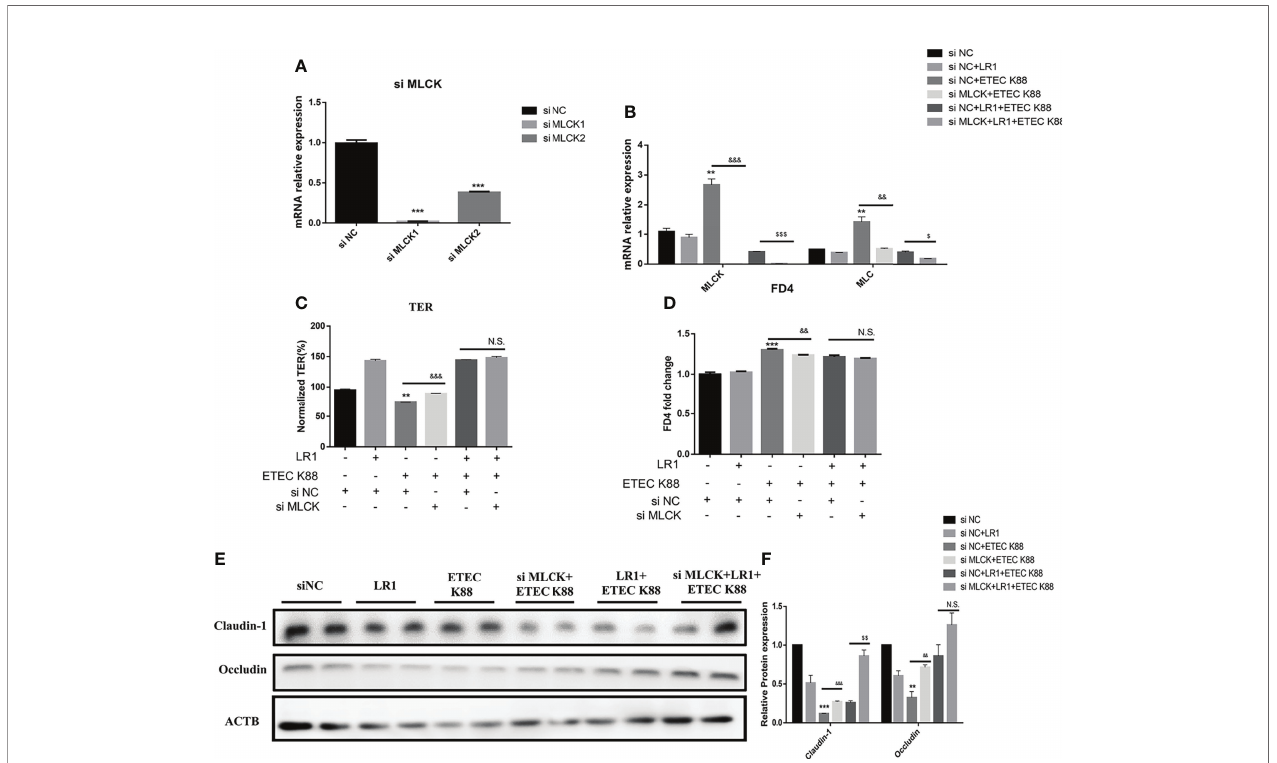
FIGURE 6 | Knockdown MLCK promotes the effects of L. reuteri LR1 on the in fl ammatory response and barrier function in IPEC-J2 cells treated with ETEC K88. (A) Relative expression of MLCK in IPEC-J2 after being treated with si Negative Control (si NC), si MLCK 1, and si MLCK 2. (B) Gene expression of MLCK and MLC determined by qPCR in IPEC-J2 cells transfected with negative control siRNA or siRNA targeting MLCK. (C) TER of IPEC-J2 cells transfected with negative control siRNA or siRNA targeting MLCK. (D) FD4 fl ux of IPEC-J2 cells transfected with negative control siRNA or siRNA targeting MLCK. (E) Protein expression of Occludin and Claudin-1 determined by Western blotting in IPEC-J2 cells transfected with control siRNA or siRNA targeting MLCK. (F) Quanti fi cation of protein expression of Occludin and Claudin-1. Cells were treated with L. reuteri LR1 (1 × 10 9 cfu/ml) for 4 h, and then followed by ETEC K88 (1 × 10 8 cfu/ml) for 4 h. siRNA transfection for 24 h before all treatments. Data presented as mean ± SEM ( n = 3). ** p < 0.01 and *** p < 0.001 vs. the control group, && p < 0.01 and &&& p < 0.001 vs. the ETEC K88 group, $$ p < 0.01 vs. the siNC+LR1+ETEC K88 group. N.S., not signi fi